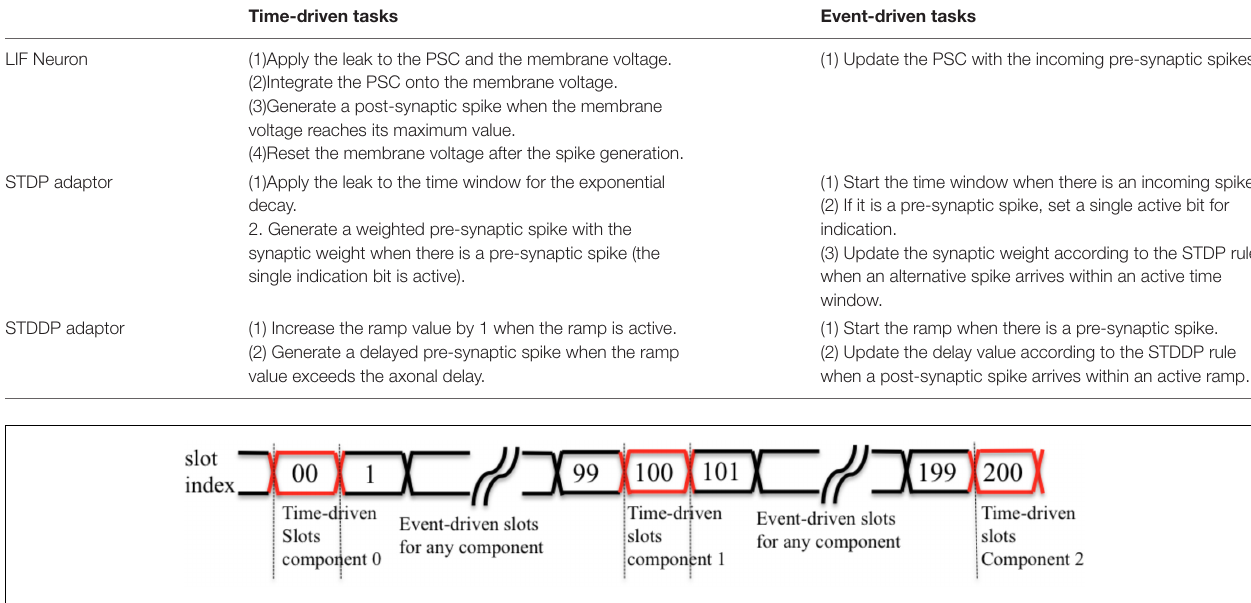
size of the neural engine from 2k components to 1k